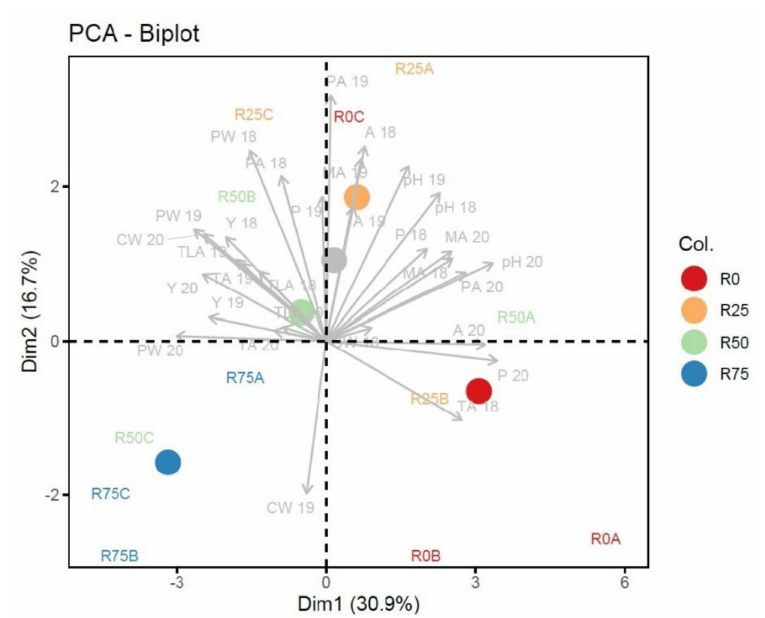
Figure 2. Principal component analysis biplot of vigor parameters, yield, and quality traits, from grape berries cv. “Touriga Francesa”, under rainfed and irrigation conditions in 2018 (18), 2019 (19), and 2020 (20) vintages. Biological replicates in the score plot, are shown with the same color within each sample type, and the length of the arrows associated with the different parameters is proportional to its contribution to the overall sample distribution. Vigor parameters: TLA—total